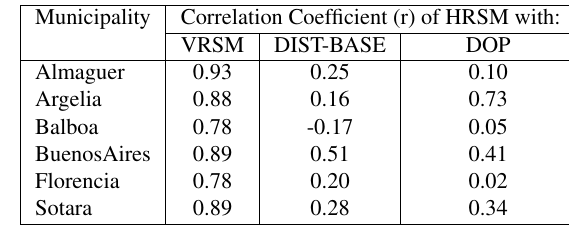
Figure 1: Differential correction